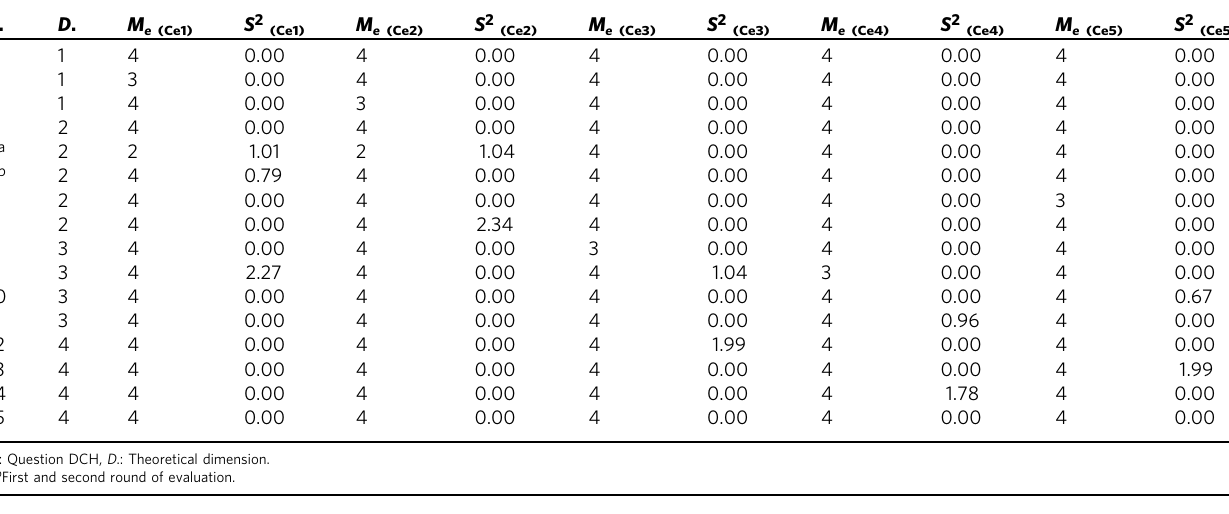
Table 4 Descriptive statistics by criterion and question.